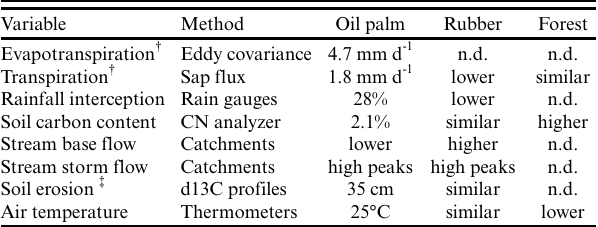
Table 2 . Characteristics of the water cycle and connected variables of oil palm plantations, rubber plantations, and forest stands as observed in the lowlands of Jambi, Indonesia (n.d. – not